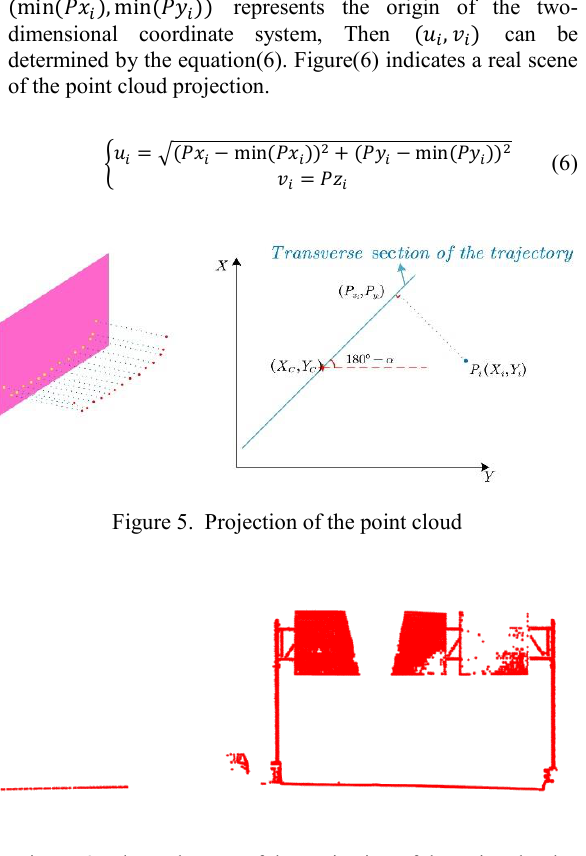
Figure 6. The real scene of the projection of the point cloud